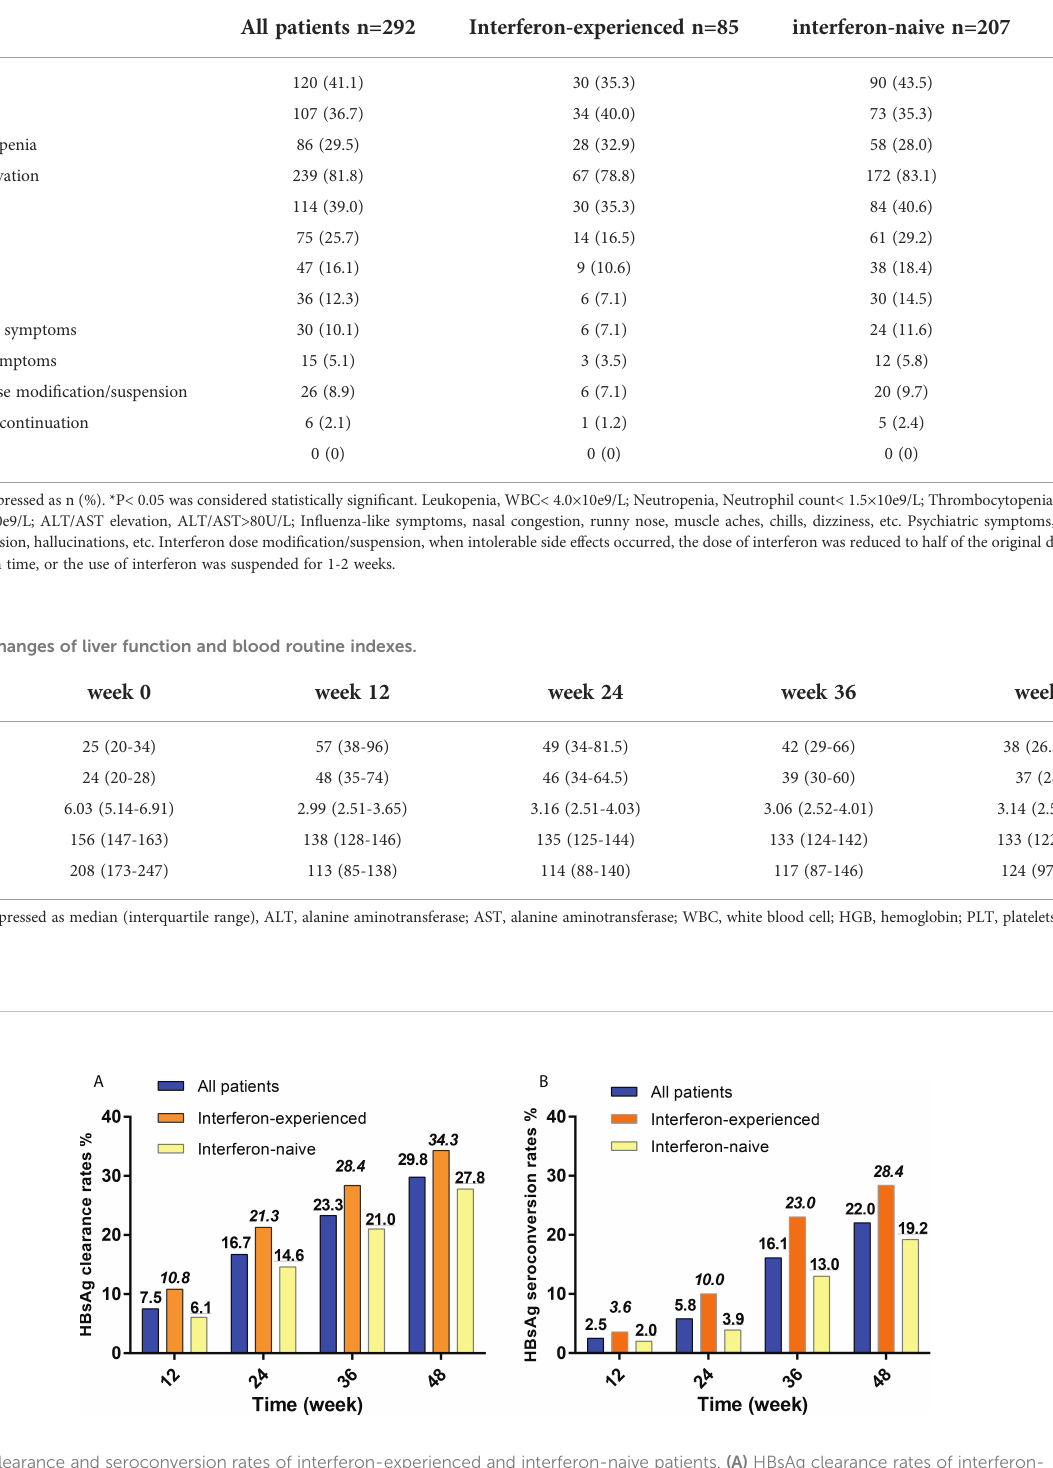
TABLE 2 Safety of the interferon add-on therapy.